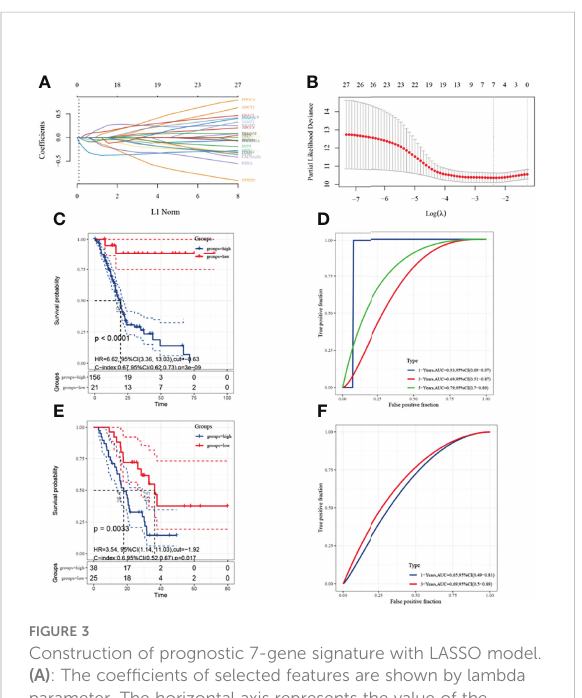
FIGURE 3 Construction of prognostic 7-gene signature with LASSO model. (A) : The coef fi cients of selected features are shown by lambda parameter. The horizontal axis represents the value of the independent variable lambda, and the vertical axis indicates the coef fi cient of the independent variable; (B) : Partial likelihood bias and log; (C, D) : KM survival curve and ROC curve based on the 7-gene signature in the training set; (E, F) : KM survival curve and ROC curve based on the 7-gene signature in the validation set. Due to the microarray samples, only the area under the curve (AUC) for 1 and 3 years is available in the ROC curves.